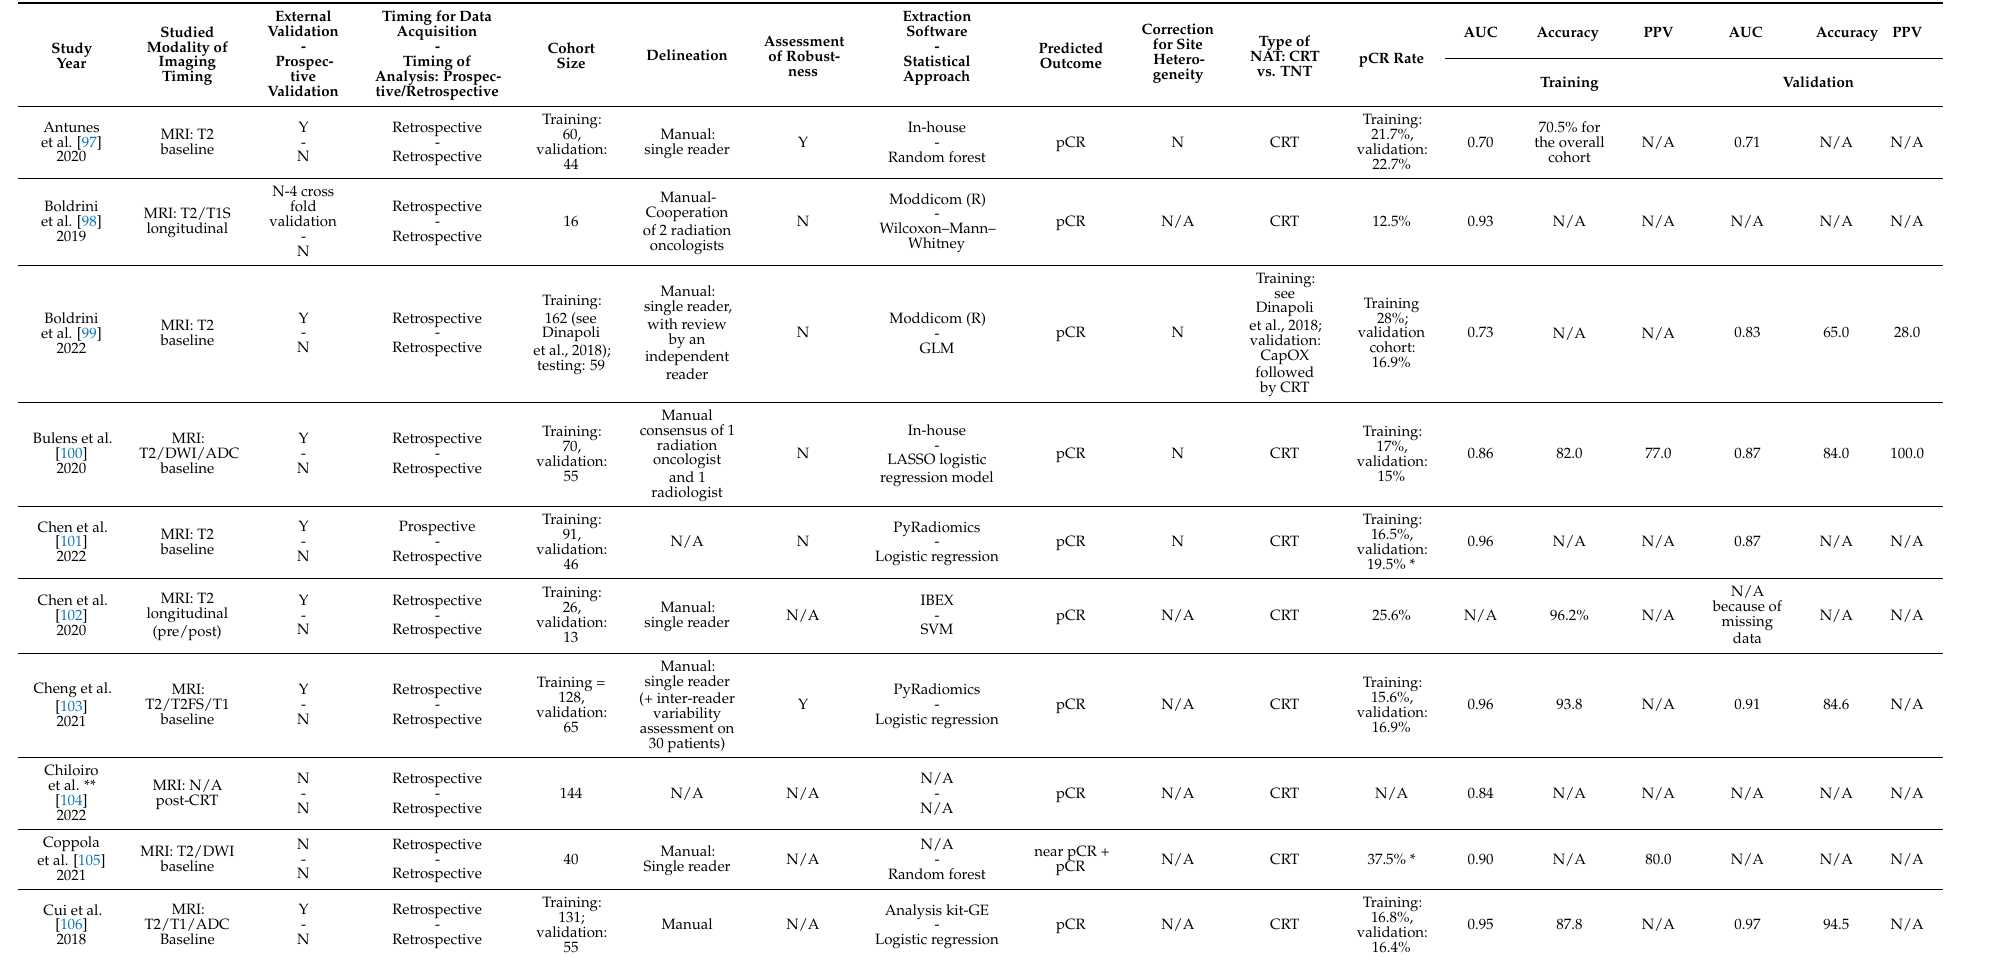
Table 1. Summary of MRI-only-based radiomics prediction